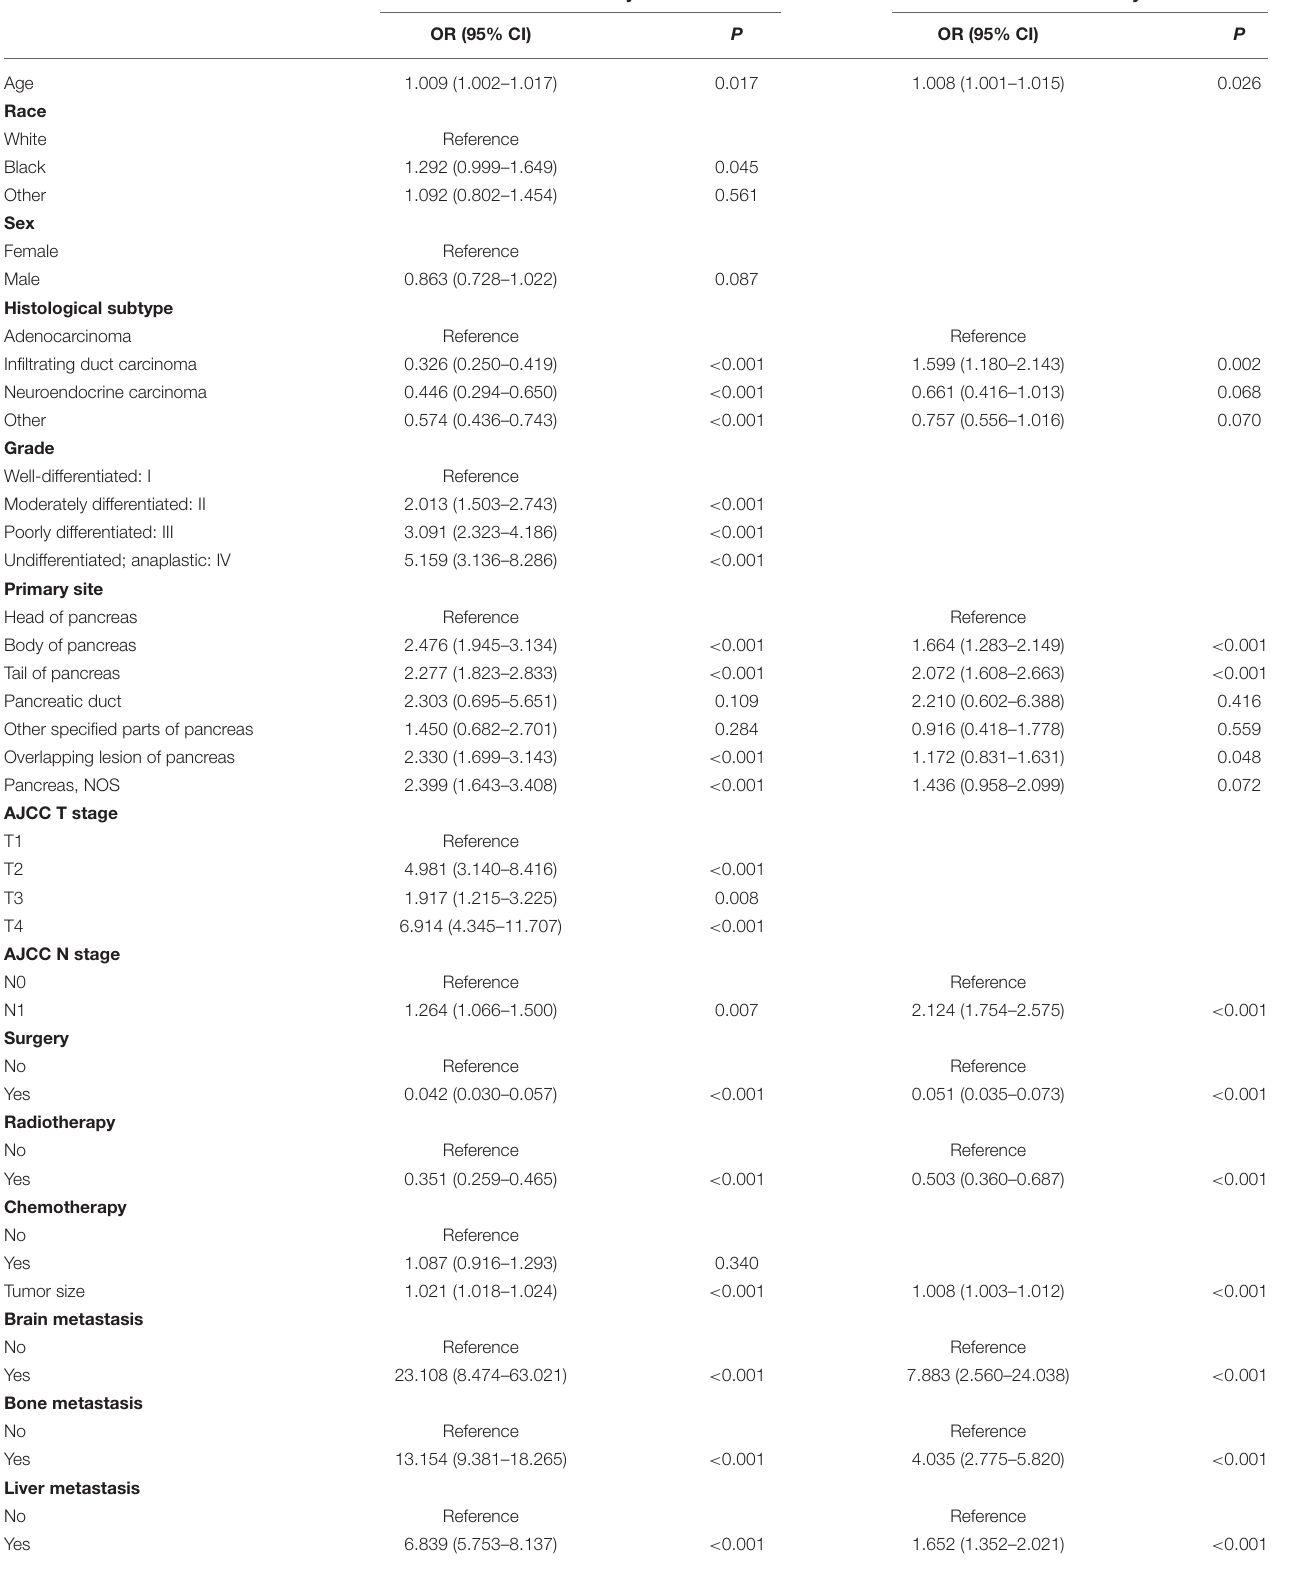
TABLE 3 | Univariable and multivariable logistic regression of risk factor of lung metastasis in pancreatic carcinoma patients.